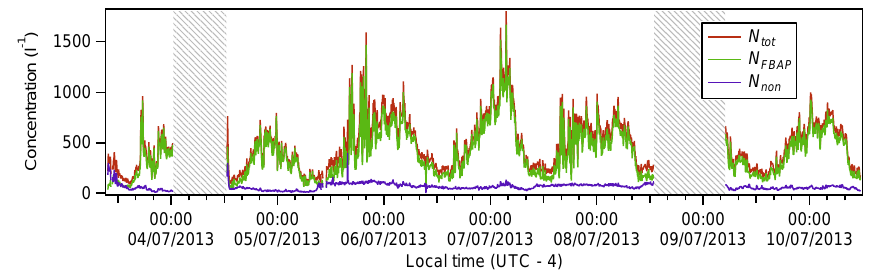
Figure 8. The time series of total, FBAP, and non-FBAP number concentrations, as measured by the WIBS-3M. Shaded areas represent pollution episodes removed from the data. Any other gaps are due to instrument downtime.